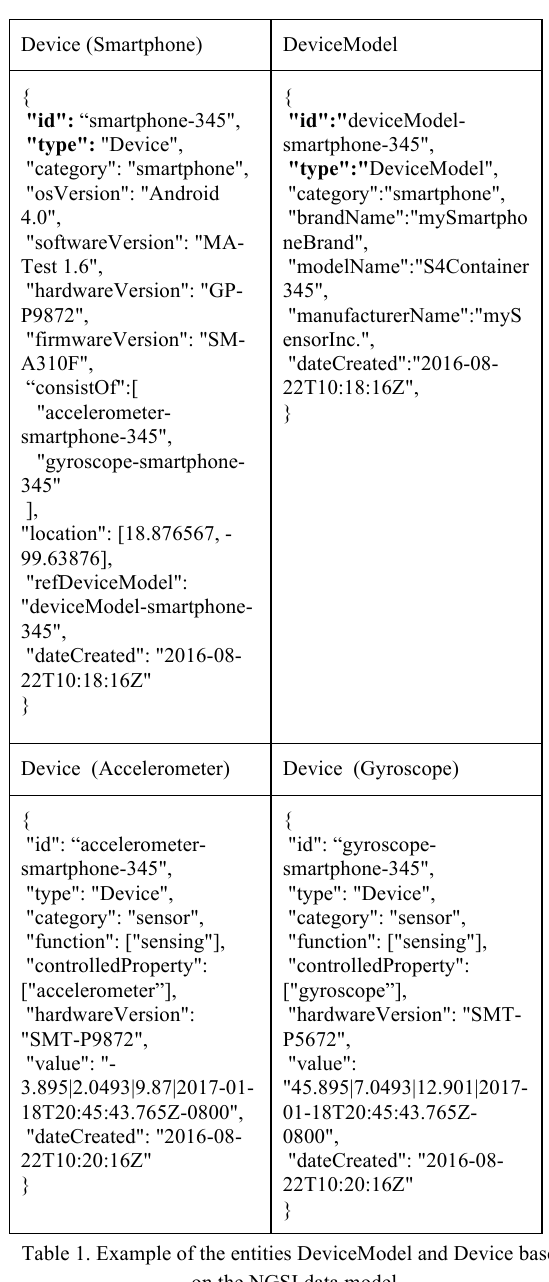
Table 1. Example of the entities DeviceModel and Device based on the NGSI data